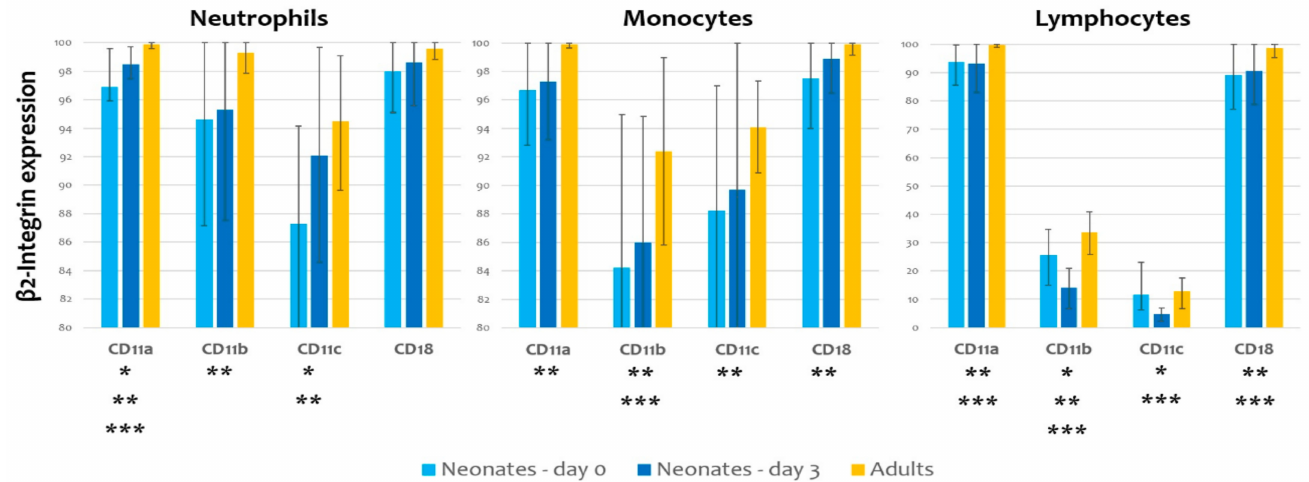
Figure 1. β 2 integrin expression on neutrophils, monocytes and lymphocytes in neonates (on day 0 and day 3) and in adults; p -value < 0.05: * Neonates day 0 vs. Neonates day 3, ** Neonates day 0 vs. Adults, *** Neonates day 3 vs. Adults.